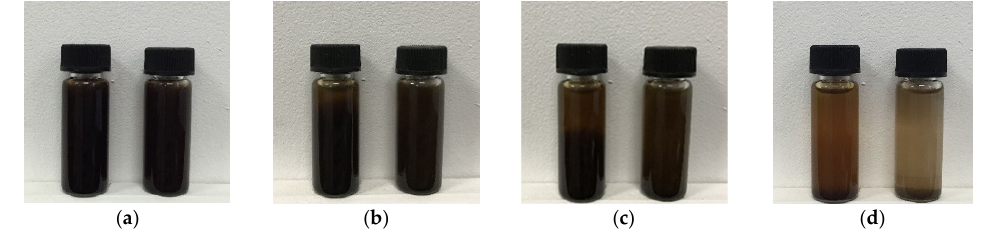
Figure 6. The dispersion of FCMSs and OCMSs in acetone solution: ( a ) Initial state; ( b ) 2 h; ( c ) 4 h; ( d ) 18 h. The left side of each picture was OCMSs and the right one is FCMSs.